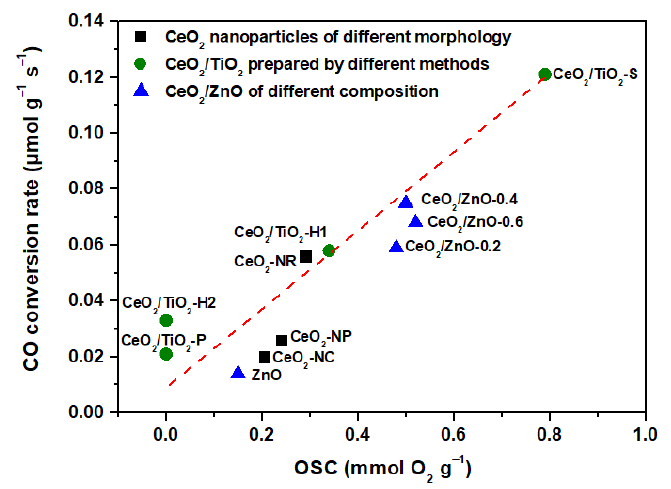
Figure 11. Relationship between the CO conversion rate at 200 °C with OSC of CeO 2 -based oxides. Symbols inside the figure refer to: nanopolyhedra (NP), nanocubes (NC), nanorods (NR), precipita- tion (P), hydrothermal method in one (H1) and two (H2) steps and Stöber method (S). Created by the authors combining data from Refs. [105,106]. Copyright© 2020, MDPI. authors combining data from Refs. [105,106]. Copyright© 2020,